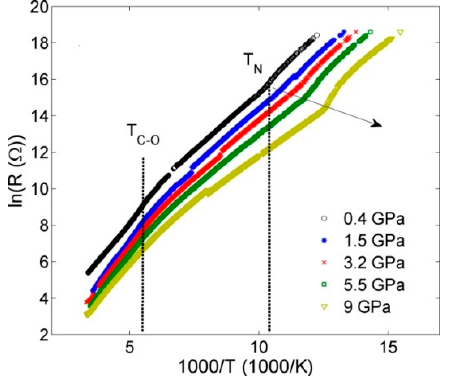
Figure 4. Arrhenius plot elaborated for the curves reported in Figure 2, limited to the thermal activated regime of NaMn 7 O 12 (P < 15 GPa).